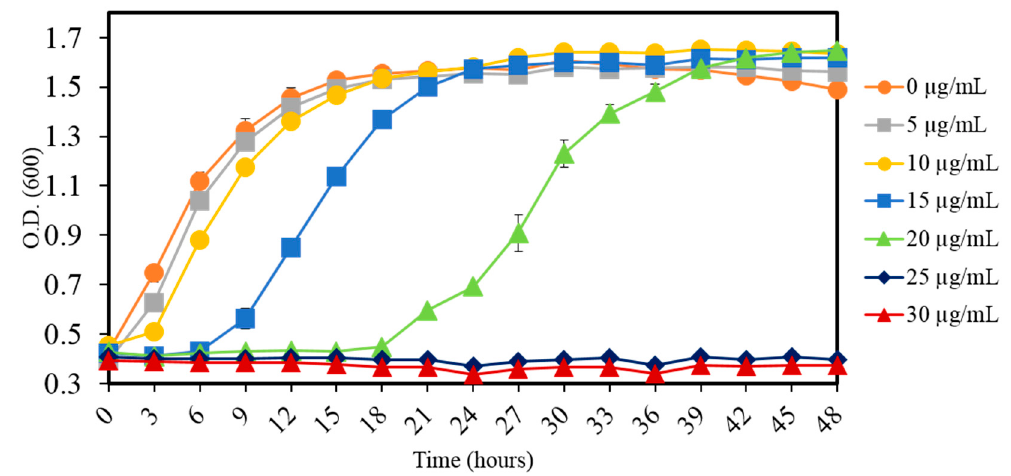
Figure 1. The growth profile of Stenotrophomonas sp. MA5 is shown, demonstrating resistance ability at different Hg concentration ranging from 0 to 30 µg/mL. The experiment was performed in triplicate and the values are shown in error bars depicting standard deviation.